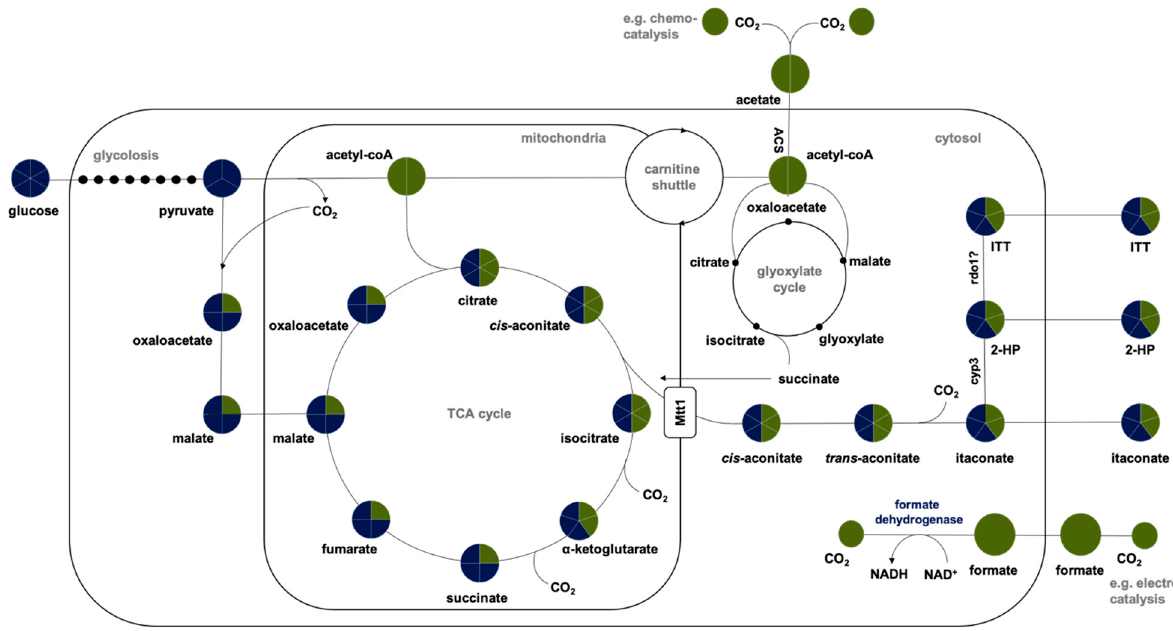
Figure 1. Itaconate biosynthesis pathway in Ustilago maydis with a proposed acetate and formate assimilation. Pyruvate is generated from glucose through glycolysis taking place in the cytoplasm. It enters the mitochondria, where it is converted to acetyl-CoA and forms citrate together with oxaloacetate during the TCA cycle. Citrate is dehydrated to cis -aconitate which is transported from the mitochondria into the cytosol via the mitochondrial tricarboxylate transporter Mtt1. In the cytosol, cis -aconitate is converted into itaconate via the intermediate trans -aconitate. Itaconate can be further converted to 2-hydroxyparaconate (2-HP) by Cyp3. 2-hydroxyparaconate might be converted to itatartarate (ITT) by Rdo1. Secretion of itaconate and possibly 2-hydroxyparaconate and itartarate into the medium is mediated by the major facilitator Itp1. Modified from [20,38]. Proposed acetate assimilation modified from [33,37]. Acetate enters the cell via passive diffusion and/or via putative acetate transporters [34,35,37]. It serves as a substrate for the enzyme acetyl-CoA synthase (ACS) [36], which converts acetate to acetyl-CoA in the cytosol [33]. Growth on acetate depends on peroxisomal activation to short acyl-CoAs including acetyl-CoA and its shuttling to the mitochondria via carnitine [37]. Proposed formate assimilation via formate dehydrogenases is known for methylotrophic microorganisms [39]. These enzymes are also present in U. maydis [40]. Indicated circle segments represent the number of carbon atoms per molecule. Blue circles indicate carbon derived from conventional glucose whereas green color indicates carbon possibly derived from CO 2 .